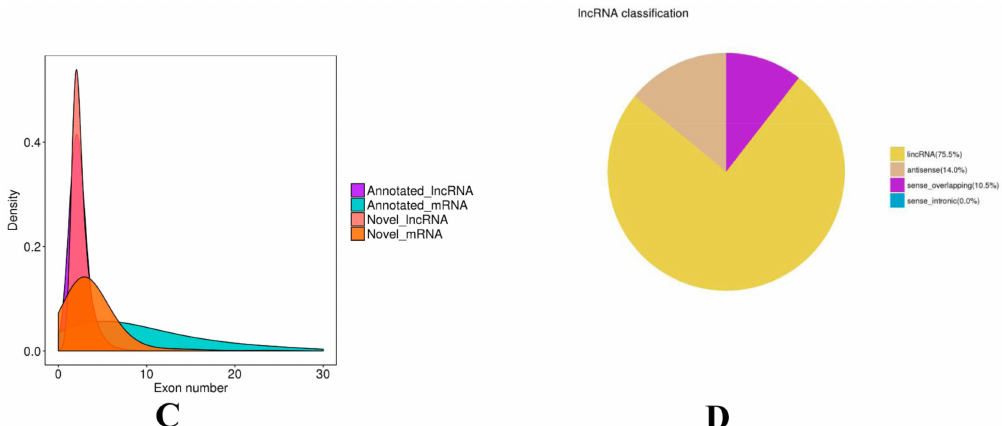
Figure 1. The classification and characteristic of lncRNAs. ( A ) The open reading frame (ORF) length of lncRNAs and mRNAs. ( B ) The length of lncRNAs and mRNAs. ( C ) The exon number of lncRNAs and mRNAs. ( D ) The classification of lncRNAs. Animals 2020 , 10 , 1035